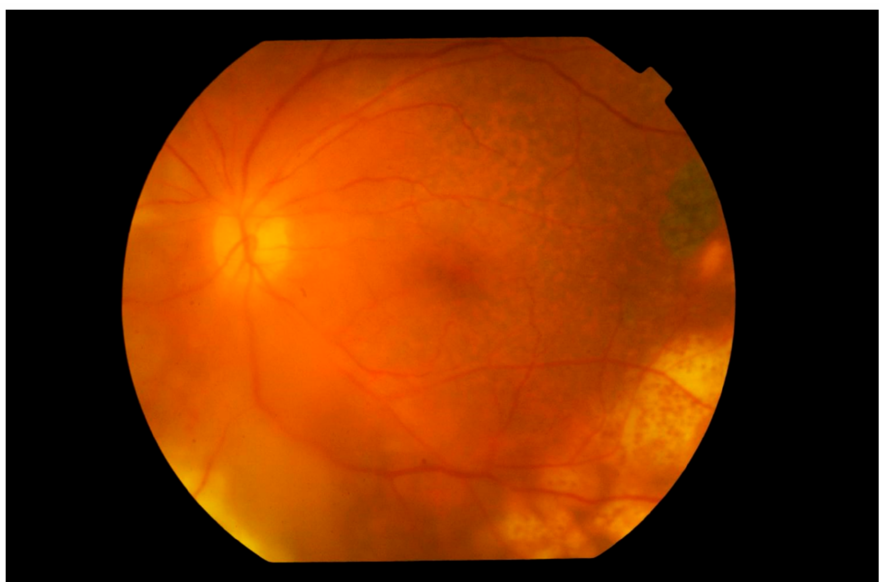
Figure 5. Photograph of the left fundus showing multiple yellowish nodular subretinal lesions with “leopard spot” pigmentation inferior temporally. Temporally to the fovea and in the superior temporal fundus, pigmentary mottling of the retina representing previous spontaneously resolved vitreoretinal lymphoma lesions is clearly seen. The vitreous is hazy but the disc appears normal. Other less common findings include necrotizing retinal infiltrates, large areas of yellow creamy infiltrates, retinal vasculitis, retinal hemorrhages (Figure 6), retinal artery occlusion and optic nerve infiltration [46,48,59,64,65]. Serous retinal detachments may also rarely be present [66–68].